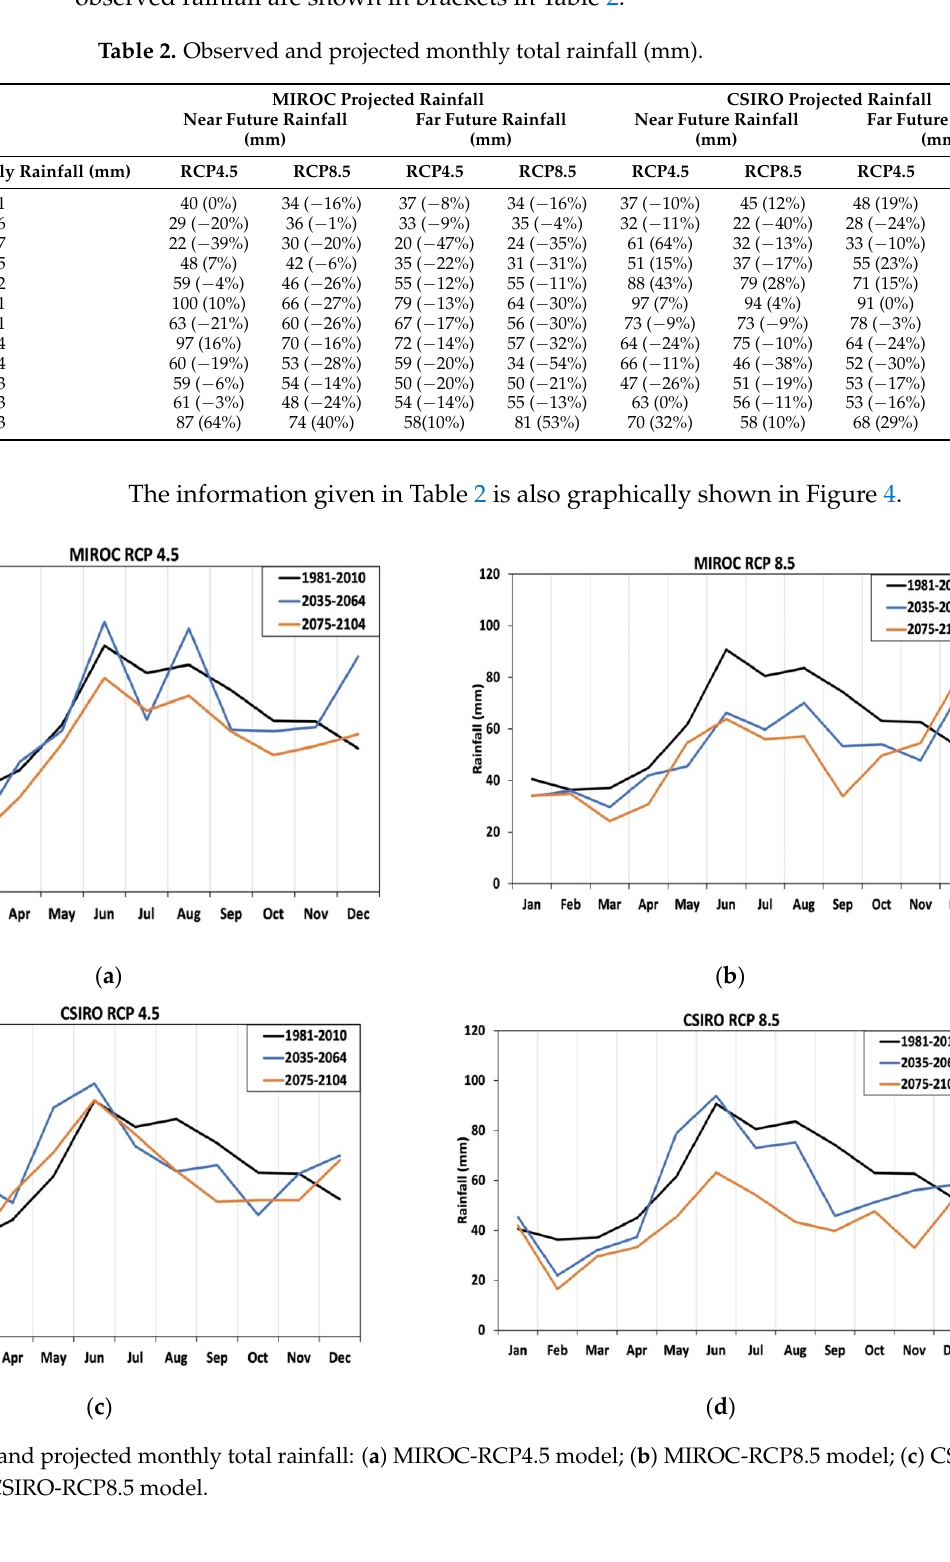
Table 2. Observed and projected monthly total rainfall (mm)